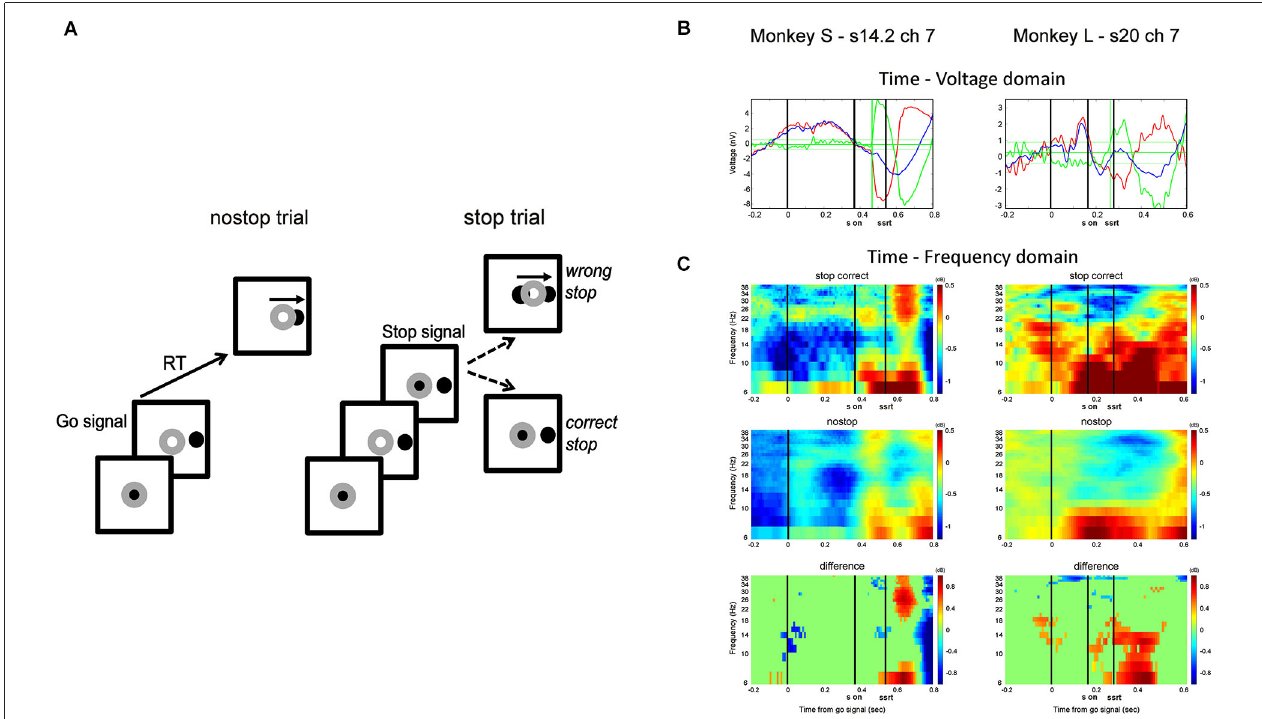
average activity of correct stop trials, the blue line is the average activity of latency-matched no-stop trials, and the green line is the difference between them. Horizontal green lines represent mean ± 2.5 SD of the difference between no-stop and correct stop trials in the 300 ms preceding the go signal (see text for further details). (C) Time-frequency plots showing the contribution of the beta and alpha bands in stop correct trials (top row) and no-stop latency-matched trials (middle row) and the difference between them (bottom row) for each monkey (S on, stop signal onset; SSRT is the estimated latency of the Stop Signal Reaction